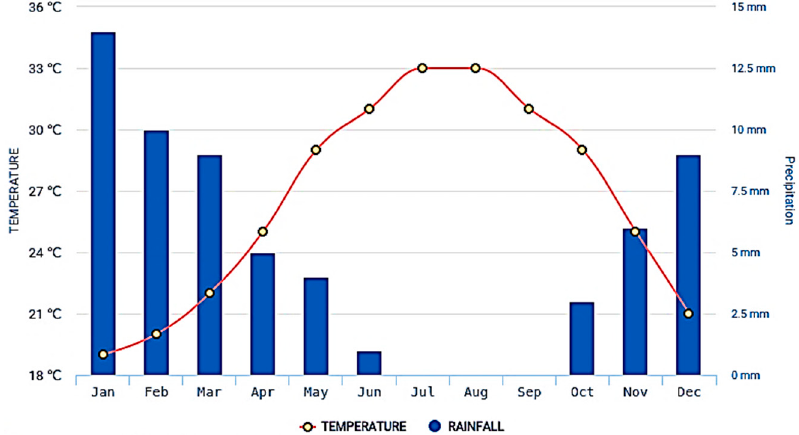
Figure 1. The average monthly temperature and precipitation during the growing season.